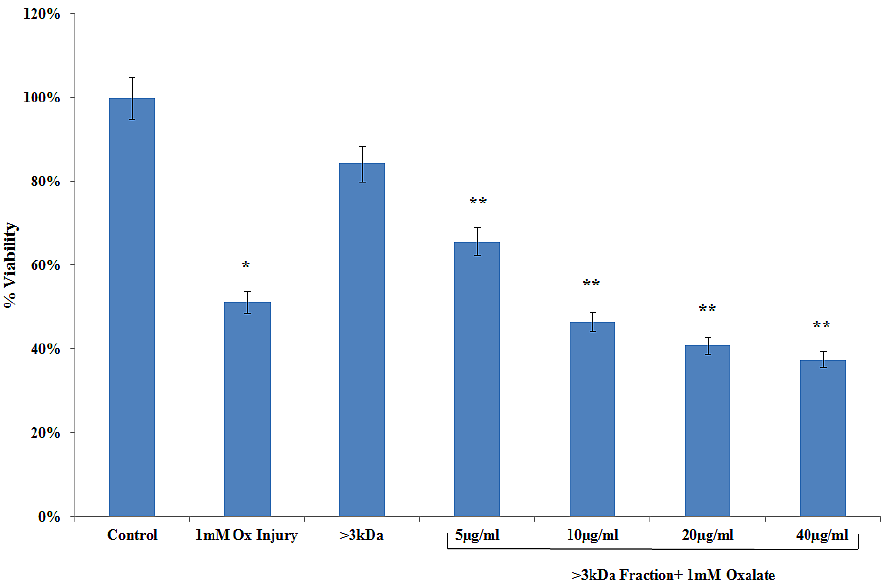
Figure 1 - Effect of >3kDa fraction on MTT assay. Data are mean ± SEM of three independent observations.